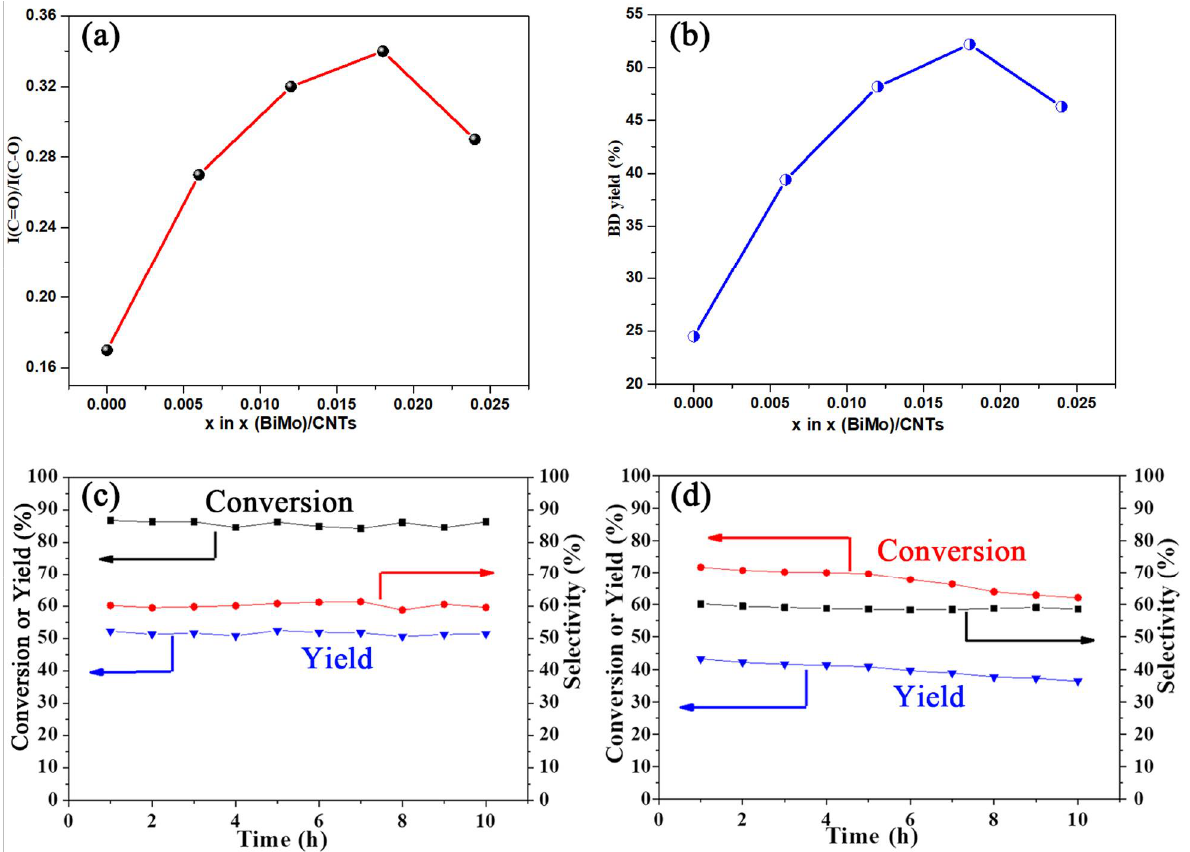
Figure 3. ( a ) I(C=O)/I(C − O) of CNT catalysts in x(BiMo)/CNTs, ( b ) the relationship of BD yield with respect to x in x(BiMo)/CNTs without water, the catalytic performance without water in the ODH reaction: conversion, yield in BD, selectivity to BD and CO 2 for ( c ) 0.018 (BiMo)/CNTs ( d ) BiMo. Table 2. Comparison of catalytic performances for different catalysts under no steam.